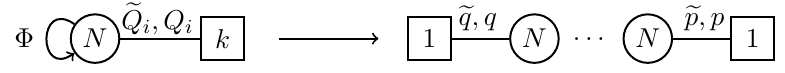
Figure 4. Adjoint U( N ) SQCD (here we indicate explicitly the adjoint with a loop) and its mirror